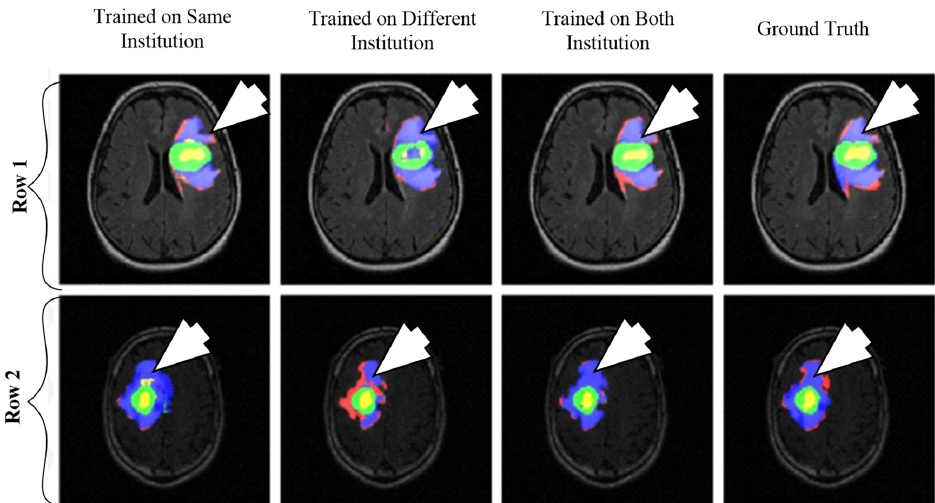
Figure 12. Segmentation results from two different patients. Class1: ground truth; Class 2 (enhancing region): green; Class 3 (necrotic region): yellow, Class 4 (T1abnormality-hypointensity region on T1, excluding enhancing and necrotic regions): red, and Class 5 (FLAIR abnormality excluding classes 2-4): blue (reproduced from [102] with permission).